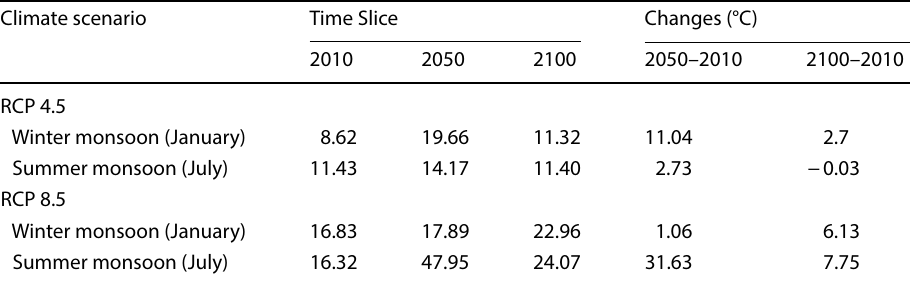
Table 6 Mean total precipitation (mm/day) under RCP 4.5 and RCP 8.5